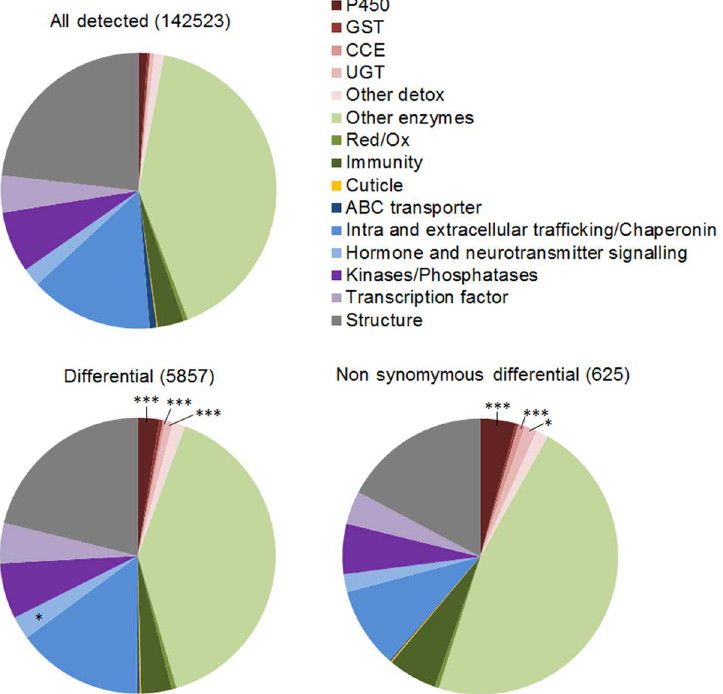
Fig 4. Gene families affectedby polymorphism variations in resistantpopulations. The frequencyof eachgenefamily was compared betweenall detectedpolymorphicSNPs (top) and both differential SNPs (Diff SNPs) and non-synonymous differentialSNPs (NS Diff SNPs) usinga one-sided Fisher’sexact test ( * p (cid:20) 0.05, *** p (cid:20)